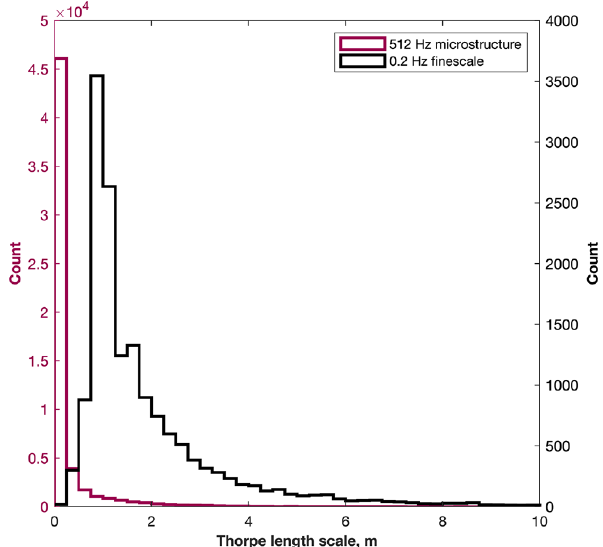
Figure 10. Histograms of Thorpe scale, L T , as calculated from FP07 microstructure observations (purple line; left-hand axis) and ordinary Seaglider finescale observations (black line; right-hand axis).